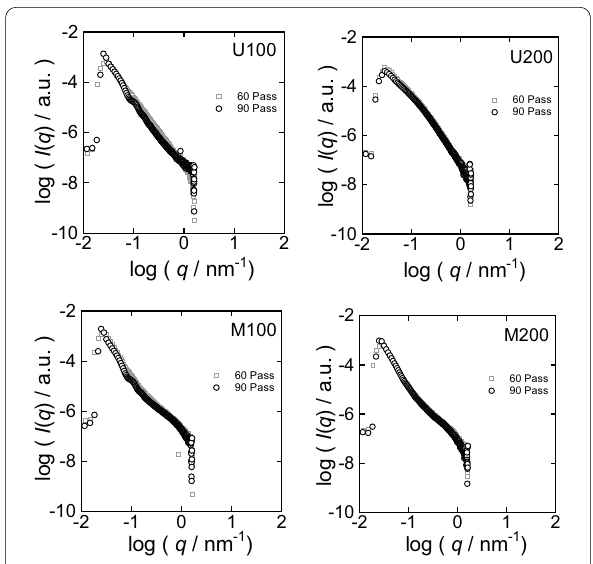
Fig. 7 Dependences of intensities, I ( q ), on scattering vector, q